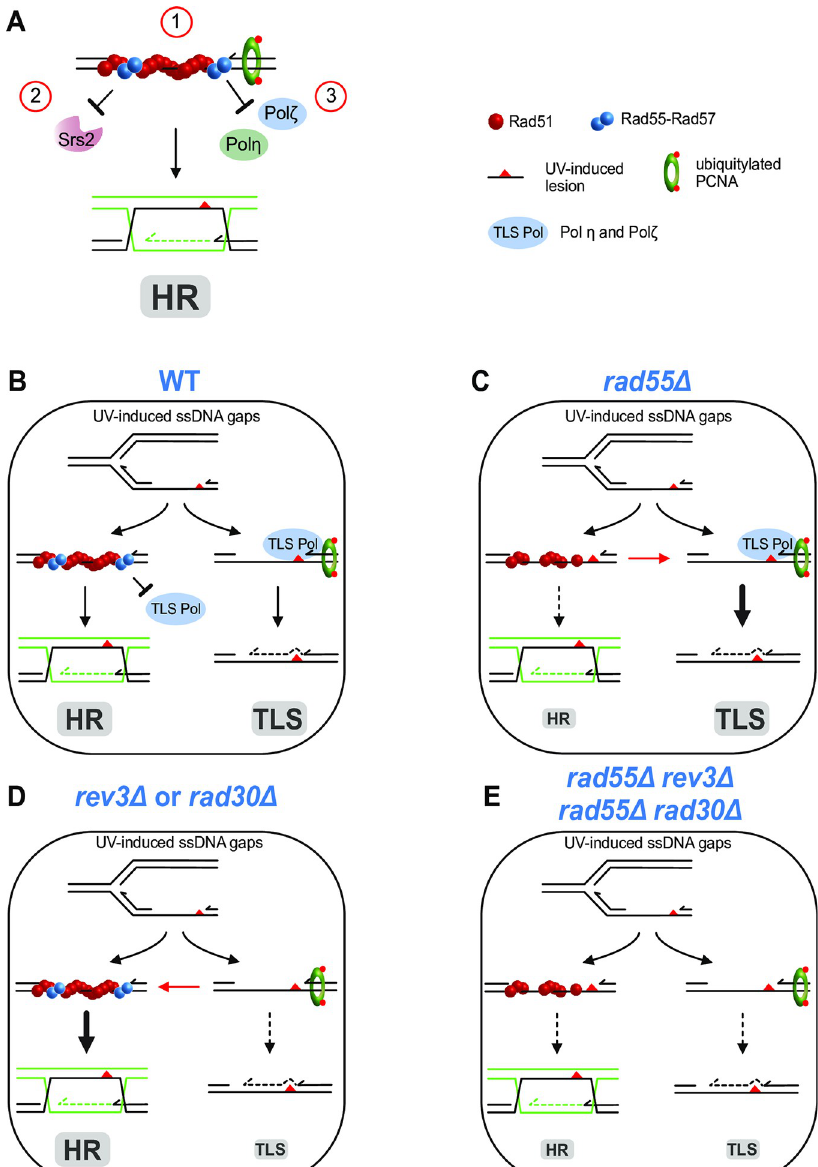
Fig 7. Model of Rad55-Rad57 roles in the repair of ssDNA gaps by HR behind replication forks. The figure shows an ssDNA gap generated after stalling of a replicative DNA polymerase at a UV-induced DNA lesion. This gap is a substrate for both the HR and TLS pathways. ( A ) The three roles of the Rad55-Rad57 complex in Rad51 filament formation on ssDNA gaps are highlighted: (1) formation of functional Rad51 filaments; (2) protection against Srs2 dismantling activity; (3) prevention of TLS polymerase recruitment at the primer/template junction. ( B ) In WT cells, Rad55-Rad57 heterodimers form and stabilize Rad51 filaments on ssDNA leading to HR, avoiding bypass by TLS. Rad51 filaments could prevent the recruitment of the TLS polymerases Pol z and Pol η (collectively named TLS Pol) by covering the 3’ extremity blocked at the DNA lesion. ( C ) In the rad55 Δ mutant, inefficient and/or fewer Rad51 filaments are formed that cannot prevent the recruitment of the TLS polymerases. Therefore, more UV-induced DNA lesions are channeled towards the TLS pathway (bold arrow). ( D ) In the rev3 Δ or in the rad30 Δ mutant, the absence of Pol z or Pol η allows channeling UV-induced DNA lesions towards the HR pathway (bold arrow). ( E ) In the rad55 Δ rev3 Δ and rad55 Δ rad30 Δ double mutants both the HR and the TLS pathways are